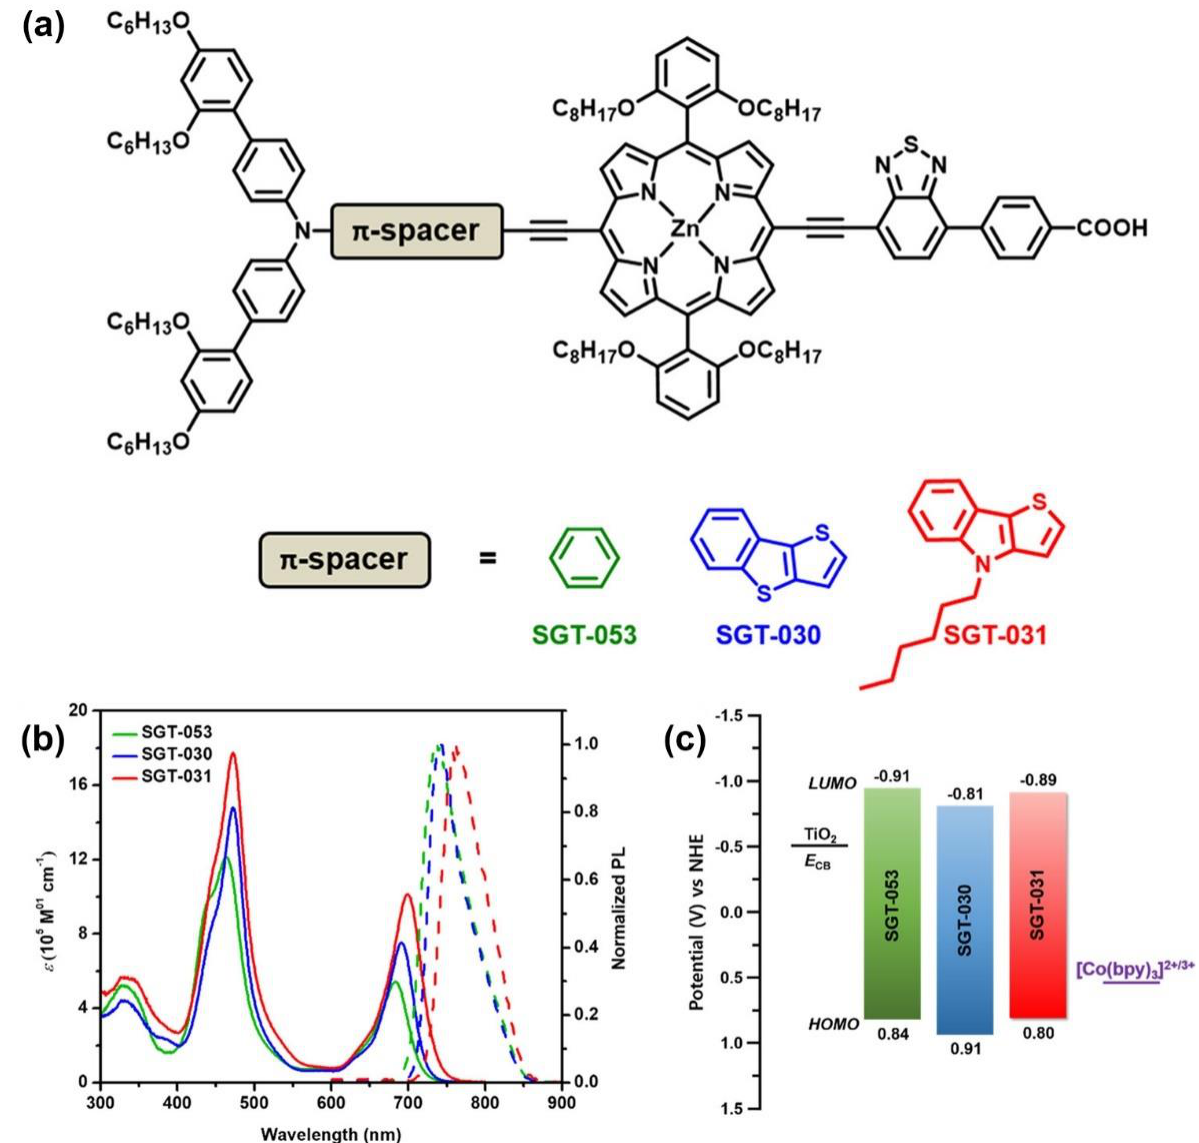
Figure 22. ( a ) Molecular structures of the porphyrin sensitizers featured by the incorporation of different spacers between the donor group and the porphyrin ring; ( b ) corresponding data of UV–vis absorption and emission spectra in THF solution; and ( c ) energy diagrams. SGT-053 = D–Ph– π –A; SGT-030 = D–TBT– π –A; SGT-031 = D–TI– π –A. Adapted from reference [92] with permission from the American Chemical Society, copyright